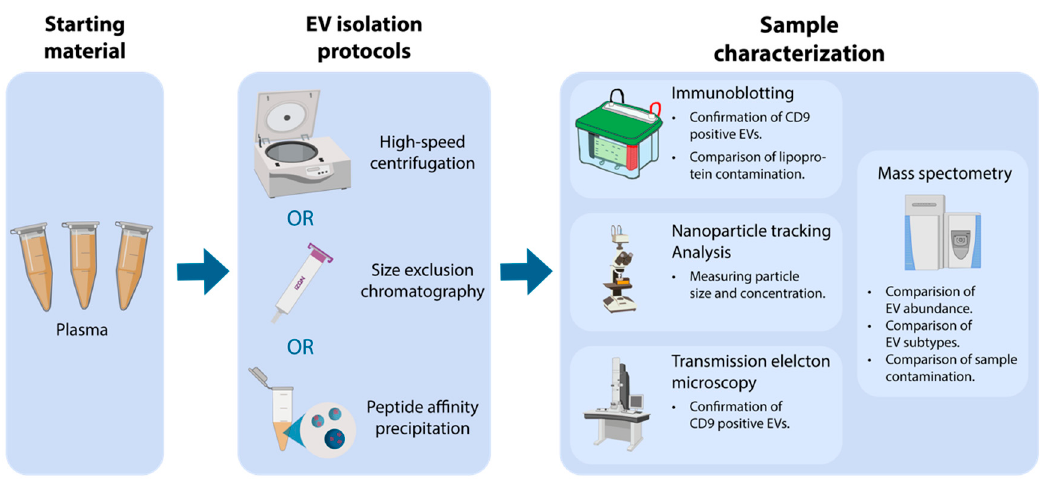
Figure 1. Overview of the applied workflow starting with plasma, isolation of extracellular vesicles (EV), followed by sample characterization. EVs were isolated using either high-speed centrifugation, size exclusion chromatography (SEC), or peptide affinity precipitation (PAP). EV isolates were characterized by nanoparticle tracking analysis (NTA), transmission electron microscopy (TEM), immunoblotting, and mass spectrometry (MS).